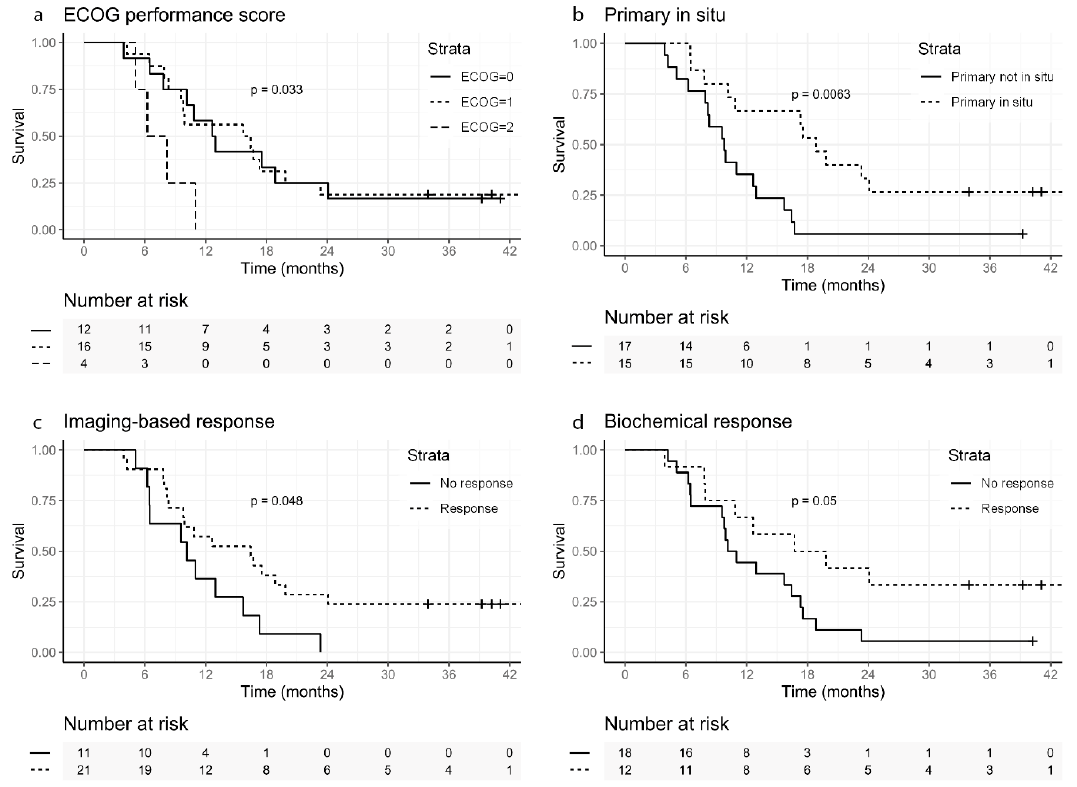
Figure 6. Kaplan–Meier curves showing the significant survival probability, expressed as a percentage, following the first cycle of [ 177 Lu]Lu-PSMA-617 treatment. ( a ): ECOG performance score, ( b ): Primary prostate in situ yes or no, ( c ): Imaging-based response ( ≥ 30 TL-PSMA reduction) yes or no, ( d ): Biochemical response (>50% PSA reduction) yes or no. Legend: ECOG = Eastern Cooperative Oncology Group.